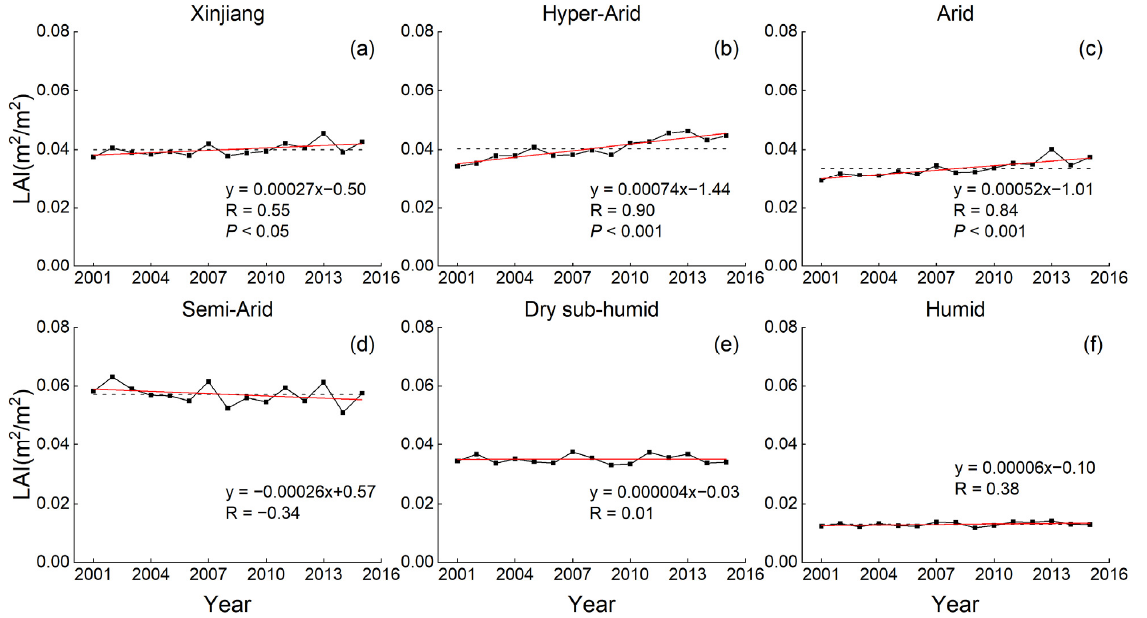
Figure 8. Inter-annual variations in LAI in different climate zones from 2001 to 2015 are shown for ( a ) the entire Xinjiang region, ( b ) hyper-arid region, ( c ) arid region, ( d ) semi-arid region, ( e ) dry sub-humid region, and ( f ) humid region.